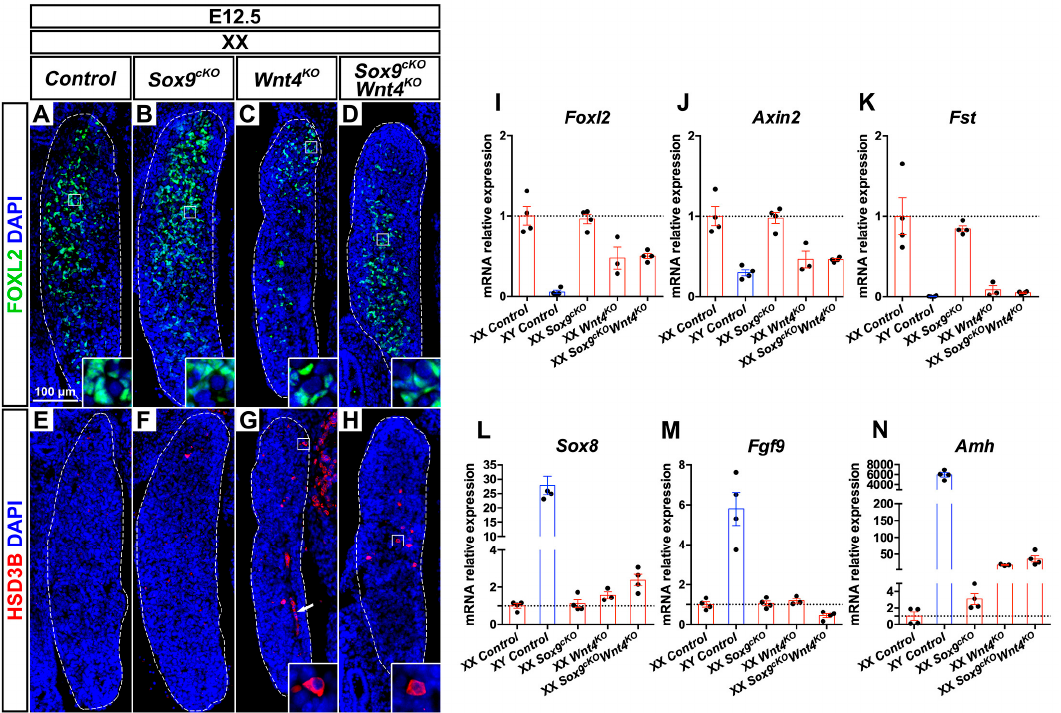
Figure 1. Early phenotypic changes in XX Wnt4 mutants are independent of SOX9 function. ( A – D ) Immunodetection of the pre-granulosa cell marker FOXL2 (green) in E12.5 XX gonads of Control ( A ), Sox9 cKO ( B ), Wnt4 KO ( C ) and Sox9 cKO Wnt4 KO ( D ) genotypes. ( E – H ) Immunodetection of the steroidogenic enzyme HSD3B (red) in E12.5 XX gonads of Control ( E ), Sox9 cKO ( F ), Wnt4 KO ( G ) and Sox9 cKO Wnt4 KO ( H ) genotypes. ( I – N ) RT-quantitative PCR analysis of Foxl2 ( I ), Axin2 ( J ), Follistatin ( Fst ) ( K ), Sox8 ( L ), Fgf9 ( M ) and Amh ( N ) expression in E12.5 gonads of XX Control , XY Control , XX Sox9 cKO , XX Wnt 4KO , and XX Sox9 cKO Wnt4 KO genotypes ( N = 3–4 embryos for each genotype). Expression level in XX controls is 1. Graphs show individual values (dots), and the mean fold-change (bars) ± SEM. Nuclei labeled with DAPI are shown in blue. Magnification is the same in all panels. Scale bar = 100 µm. Gonads are outlined with broken white lines. White arrow in G indicates the coelomic vessel.